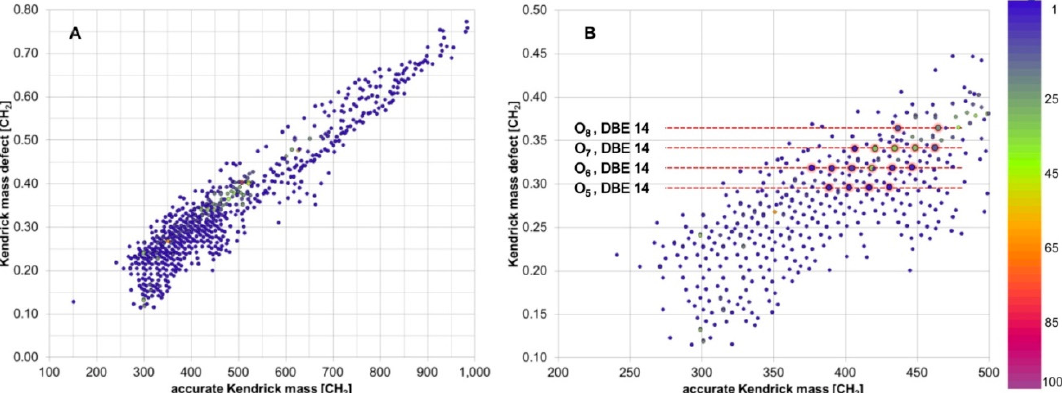
Figure 7. Kendrick mass defect (KMD) plots of a degraded lignin sample for ( A ) all measured m / z features; ( B ) restricted to monomeric/dimeric/trimeric content. Color scale represents relative intensity. Reprinted from Dier et al., with permission from the American Chemical Society [68].